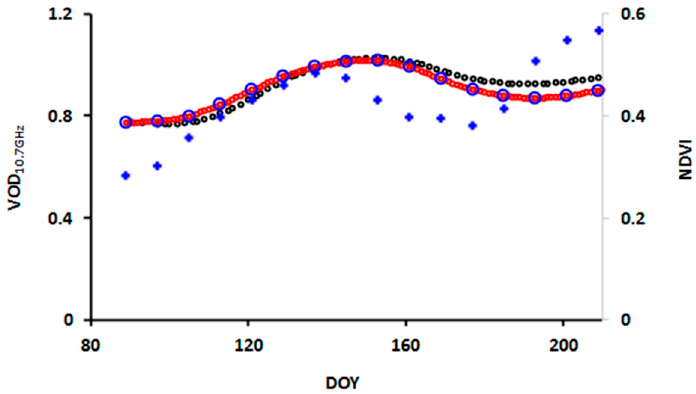
Figure 3. Example of the filtering and temporal alignment of the vegetation optical depth (VOD) data with MODIS data. The unfiltered VOD time series appears in the black circles, the eight-day forward moving average filtered VOD data appears at the blue circles, and the MODIS NBAR NDVI appears in blue pluses.